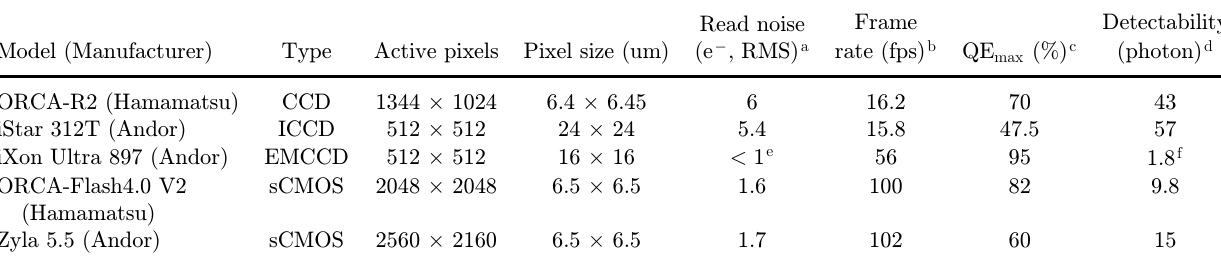
Table 1. Speci¯cations of several representative low-light cameras (as of February